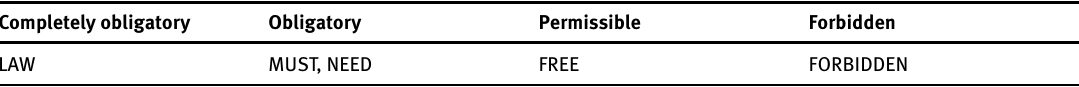
Table 4: deontic scale in